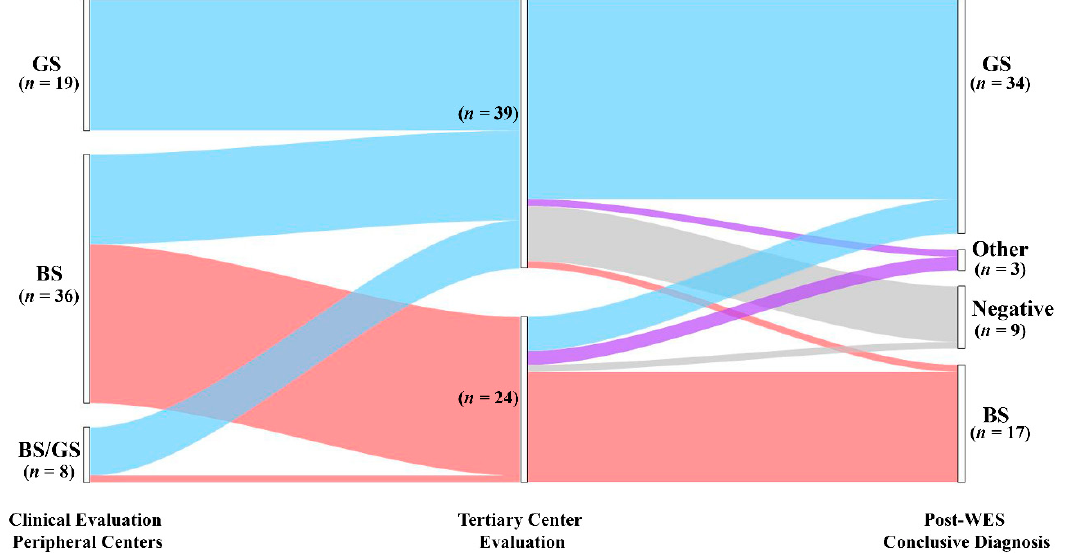
Figure 1. Diagnostic yield and disease reclassification. Patients are initially classified based on the clinical suspicion raised by referring physicians (left node). The clinical diagnosis was reframed during pre-WES consultation (middle node). All the patients underwent genetic testing with WES that allowed us to confirm or reclassify the clinical diagnosis (right node). GS, Gitelman syndrome; BS, Bartter syndrome; Other: genetic diagnosis outside BS and GS; Negative: patients without pathogenic variants.